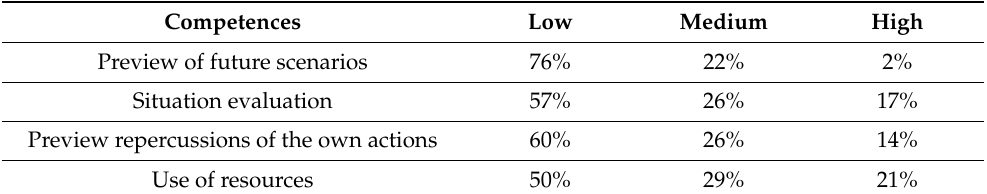
Table 3. General trend of competences expression among the sample. Competences